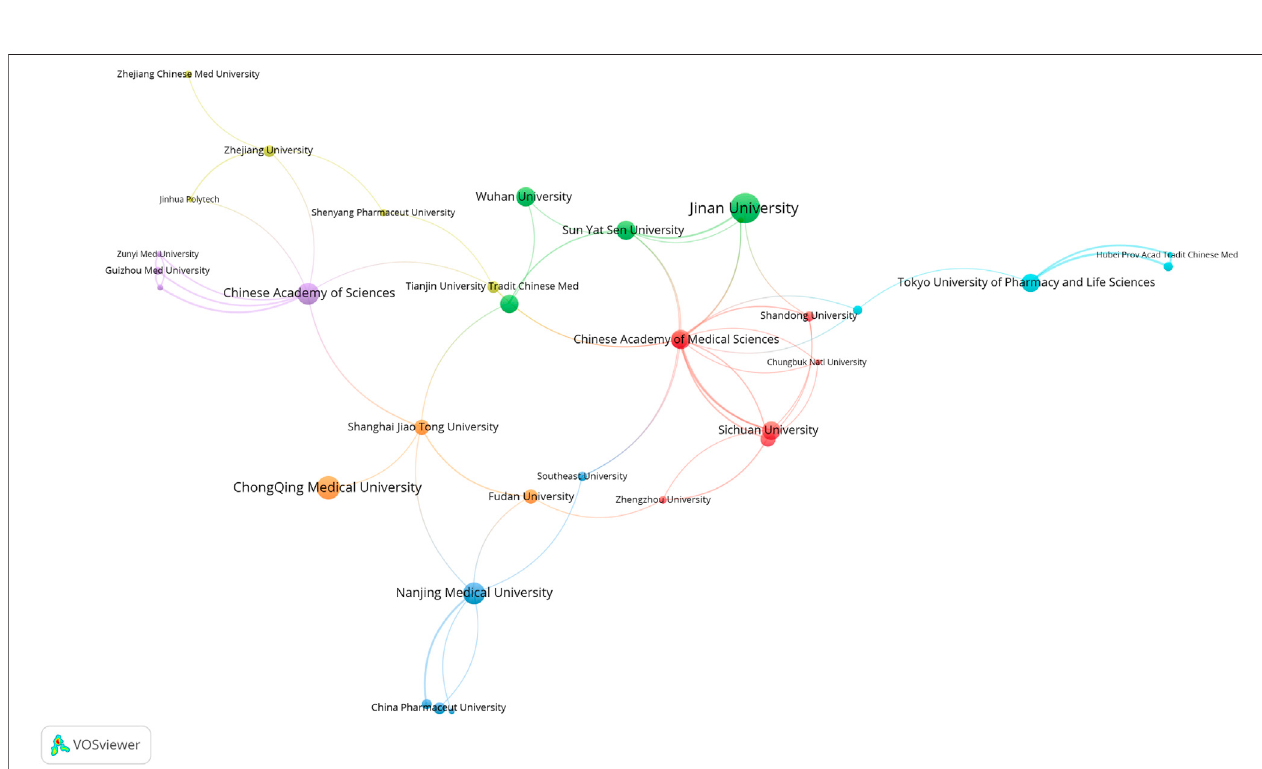
FIGURE 10 | Network visualization of institutions collaboration.